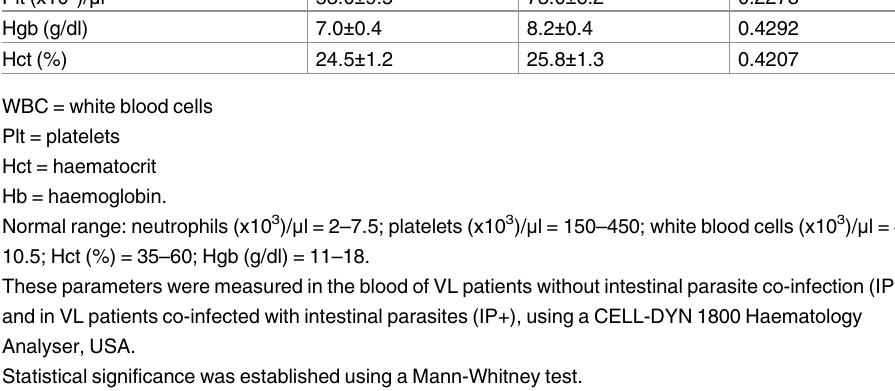
Table 3. Comparison of complete blood count. IP- IP+